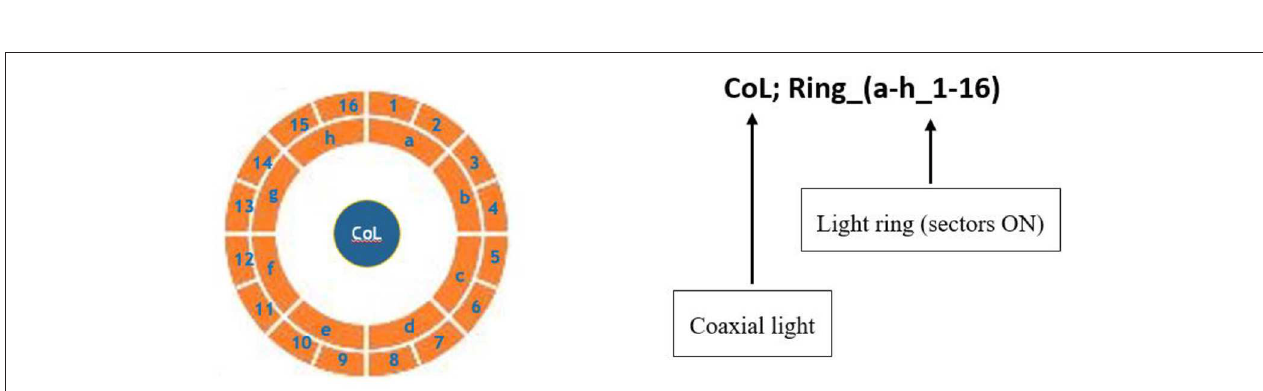
FIGURE 1 | The view of the tested surface on the device—setting of the sample in relation to axis Y: (A) the view of the device, (B) the view of the actual surface, and (C) the view of surface topography.